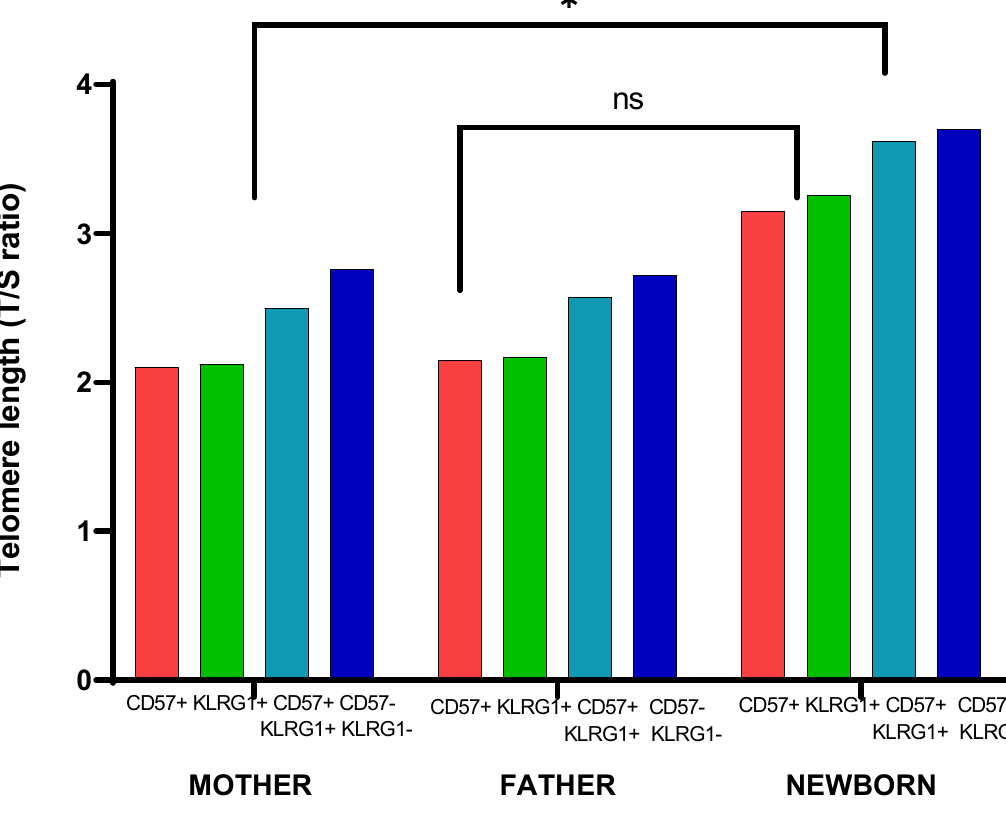
Figure 8. Comparison between telomere length and immune markers (CD57, KLRG1) in the triad: significant results (* p < 0.05) among mothers and newborns, whereas insignificant ( p > 0.05) results between fathers and newborns. ns: not significant.